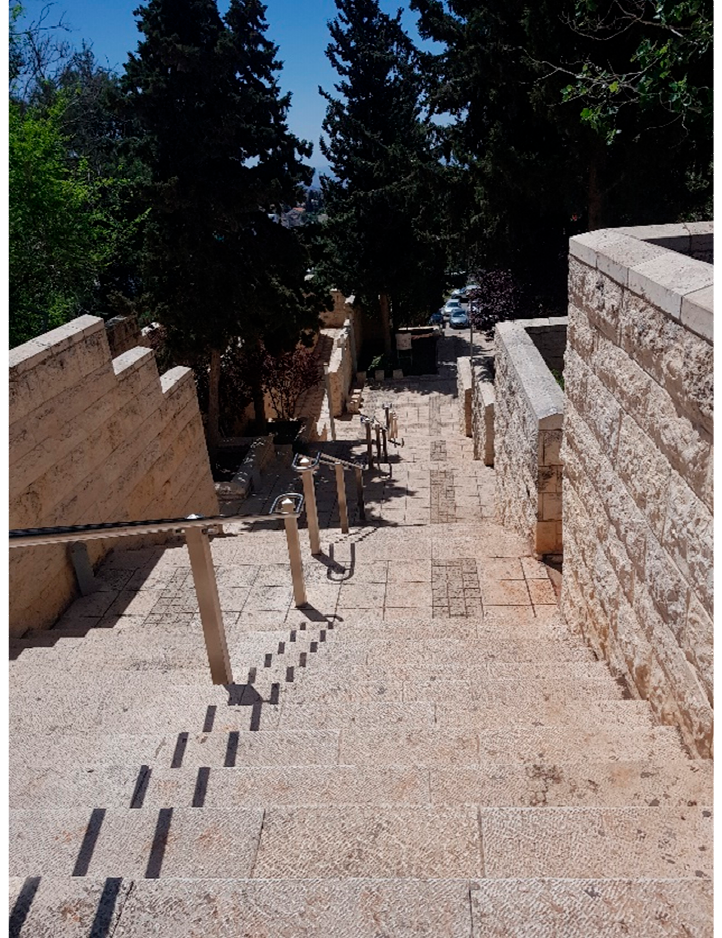
Figure 12. Stairs and drainage infrastructures around the building (Maintenance Indicator = 2.75).